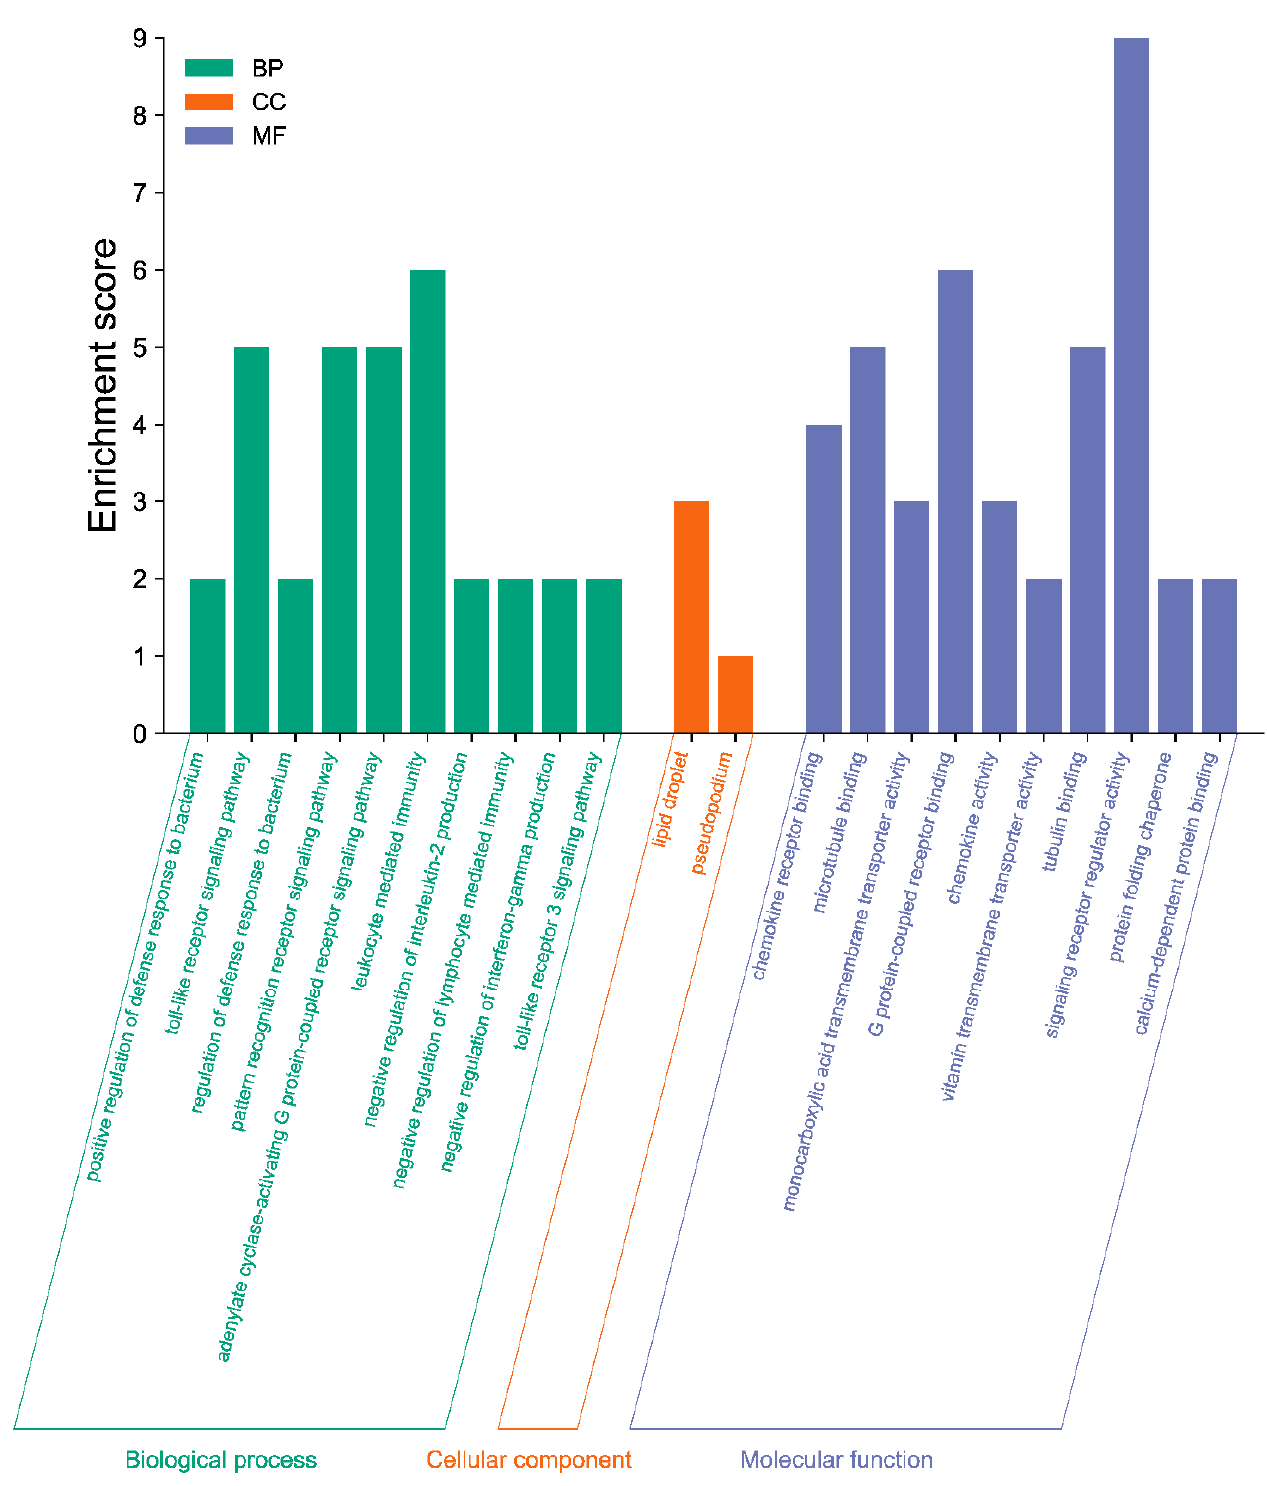
Figure 5. Most highly enriched GO terms of DEGs between H group and L group. The y-axis displays the number of DEGs, and the x-axis represents the GO terms. The bar colors correspond to different GO categories, with purple for molecular function, green for biological process, and orange for cellular component.